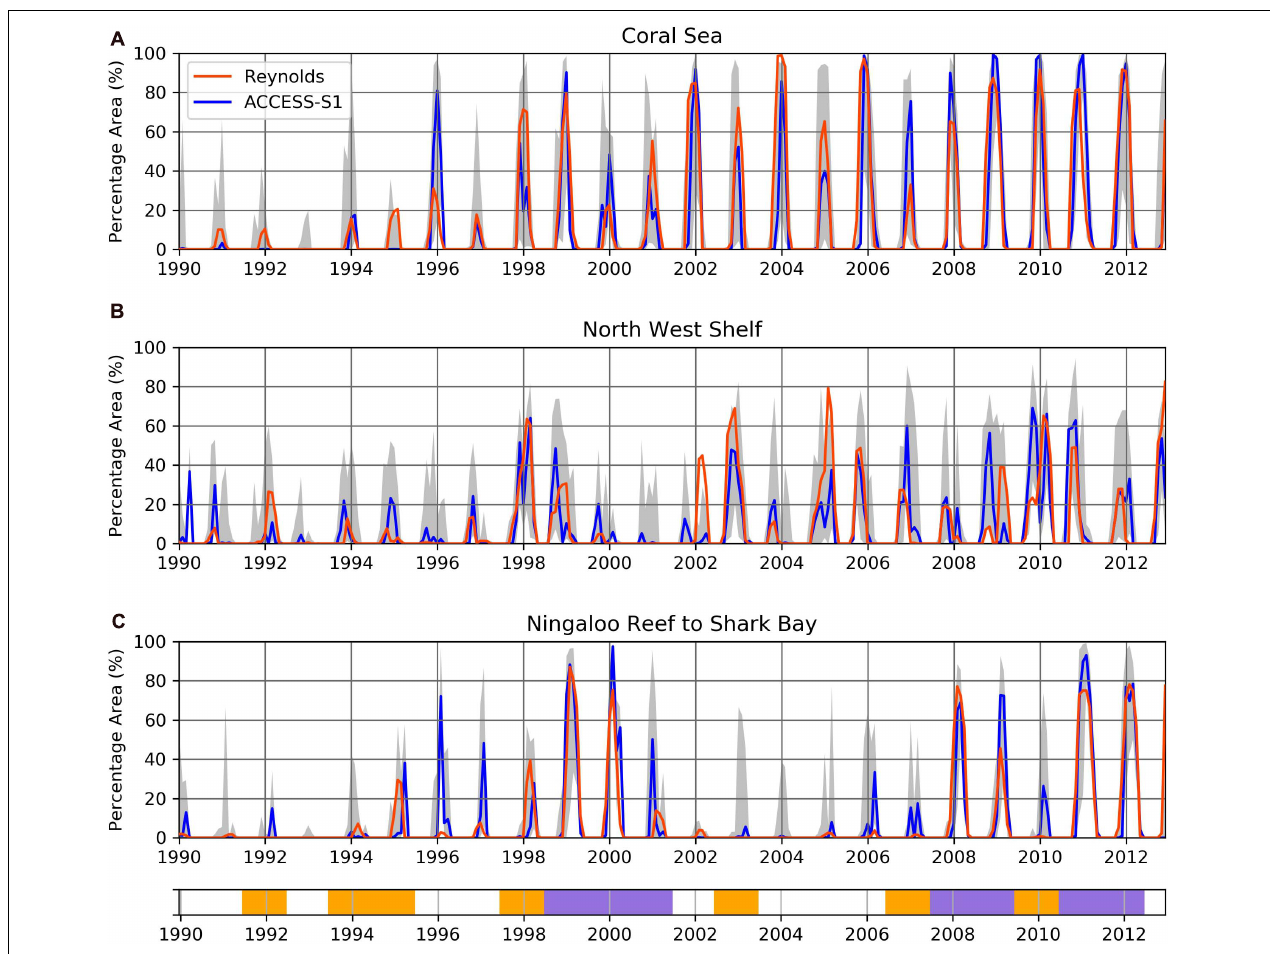
FIGURE 4 | Percentage of each region where DHM > 1 were observed and predicted for the (A) Coral Sea, (B) NW Shelf, and (C) Ningaloo to Shark Bay for 1990–2012 at lead time 0 month. Yellow shading indicates timing of El Niño events and purple shading La Niña events, as per Bureau of Meteorology definitions (http://www.bom.gov.au/climate/enso/enlist/). Gray shading shows the ensemble range. See Figure 1 for locations of